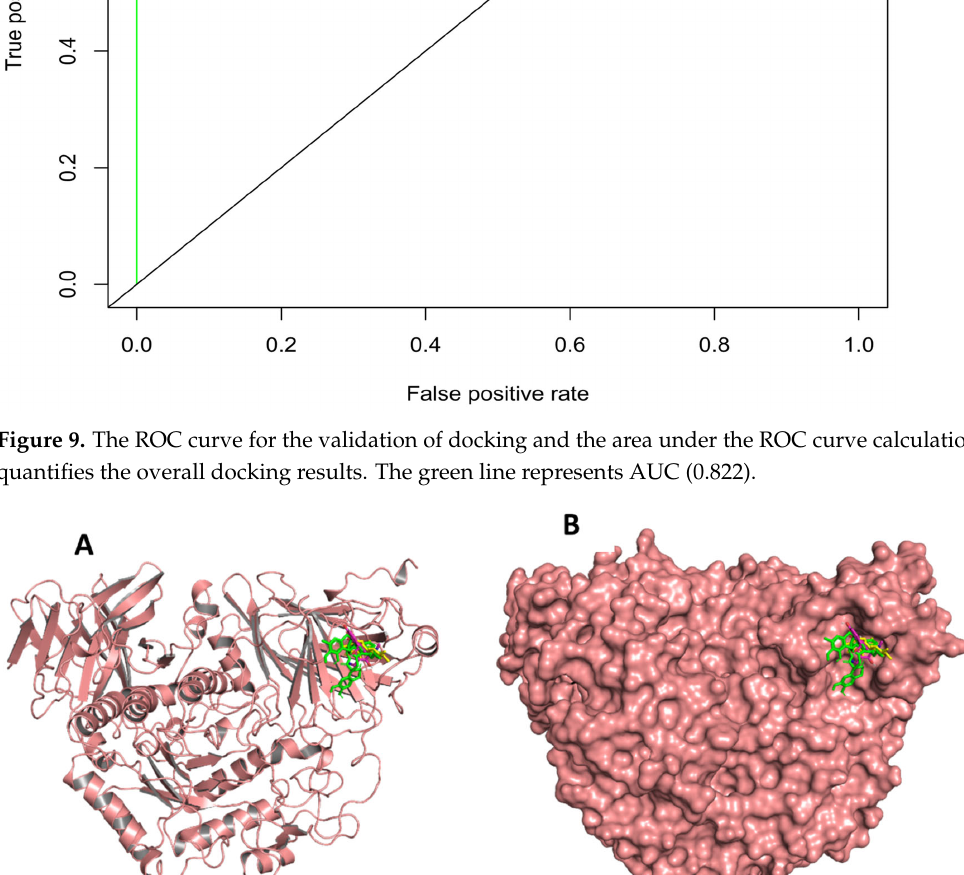
Figure 10. The superimposition of the lead compounds and reported active compounds in the cartoon ( A ) and surface form ( B ). All compounds make interactions with active site